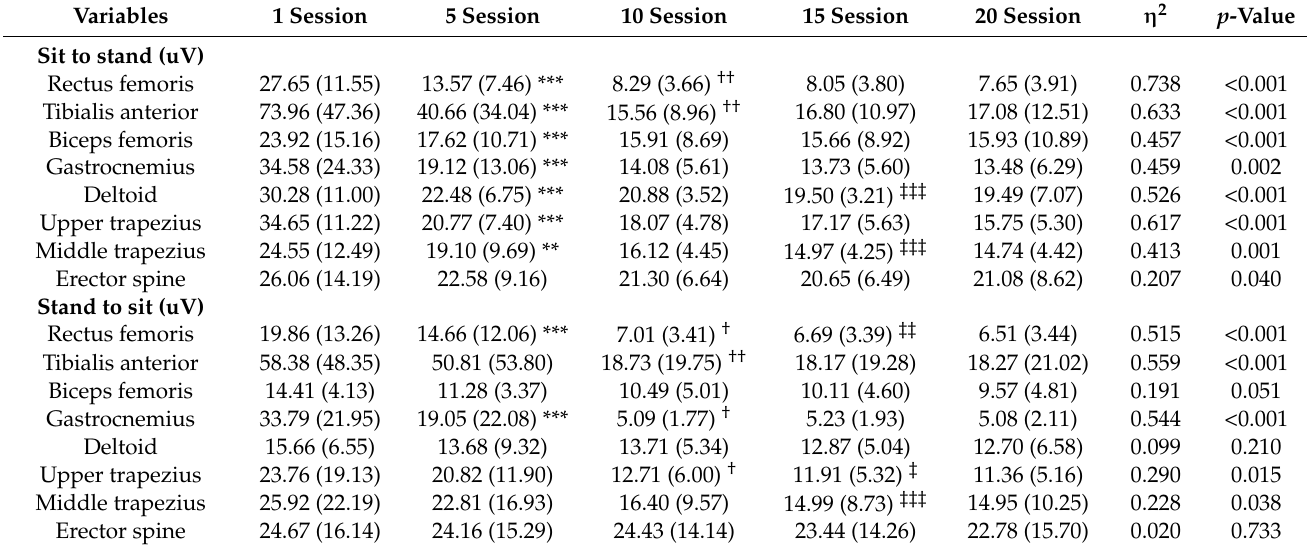
Table A2. Muscle activity in dynamic condition during the locomotion training